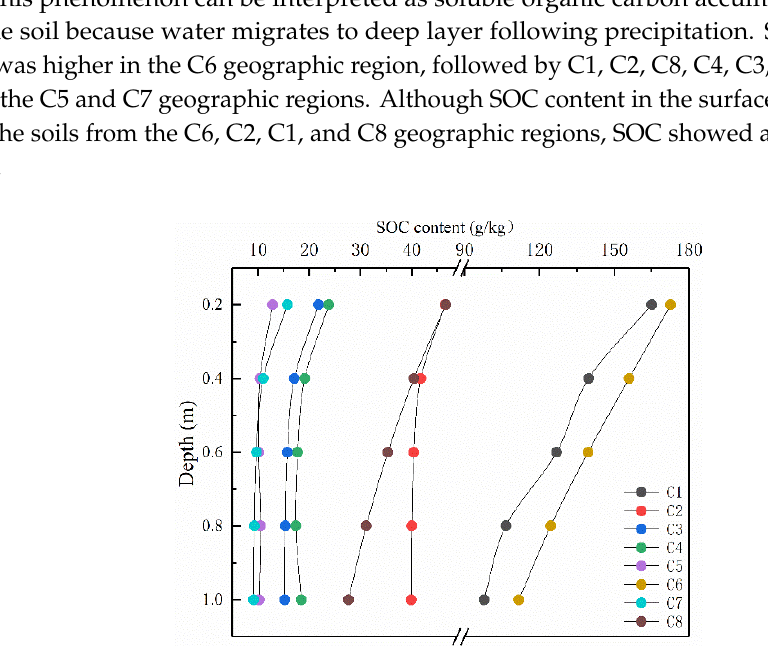
Table 2. RDA results between SOC content and environmental variables.